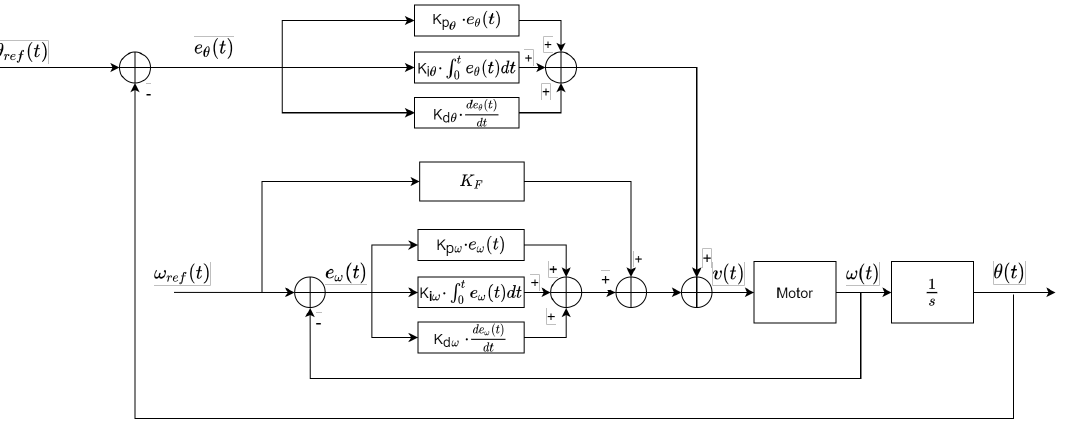
Figure 4. Controller Block